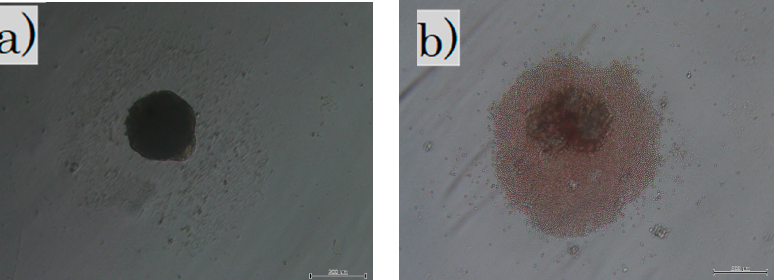
Figure 1. Cells in culture: ( a ) in the LS group, fibroblasts were cultured in non-adherent wells for 3 weeks; ( b ) in the SS group, all skins were cultured in non-adherent wells for 3 days. The dark shadow in the center is a sphere of cells and debris is seen around it. LS, long-term sphere culture; SS, short-term sphere-forming culture (scale bar 200 µm).